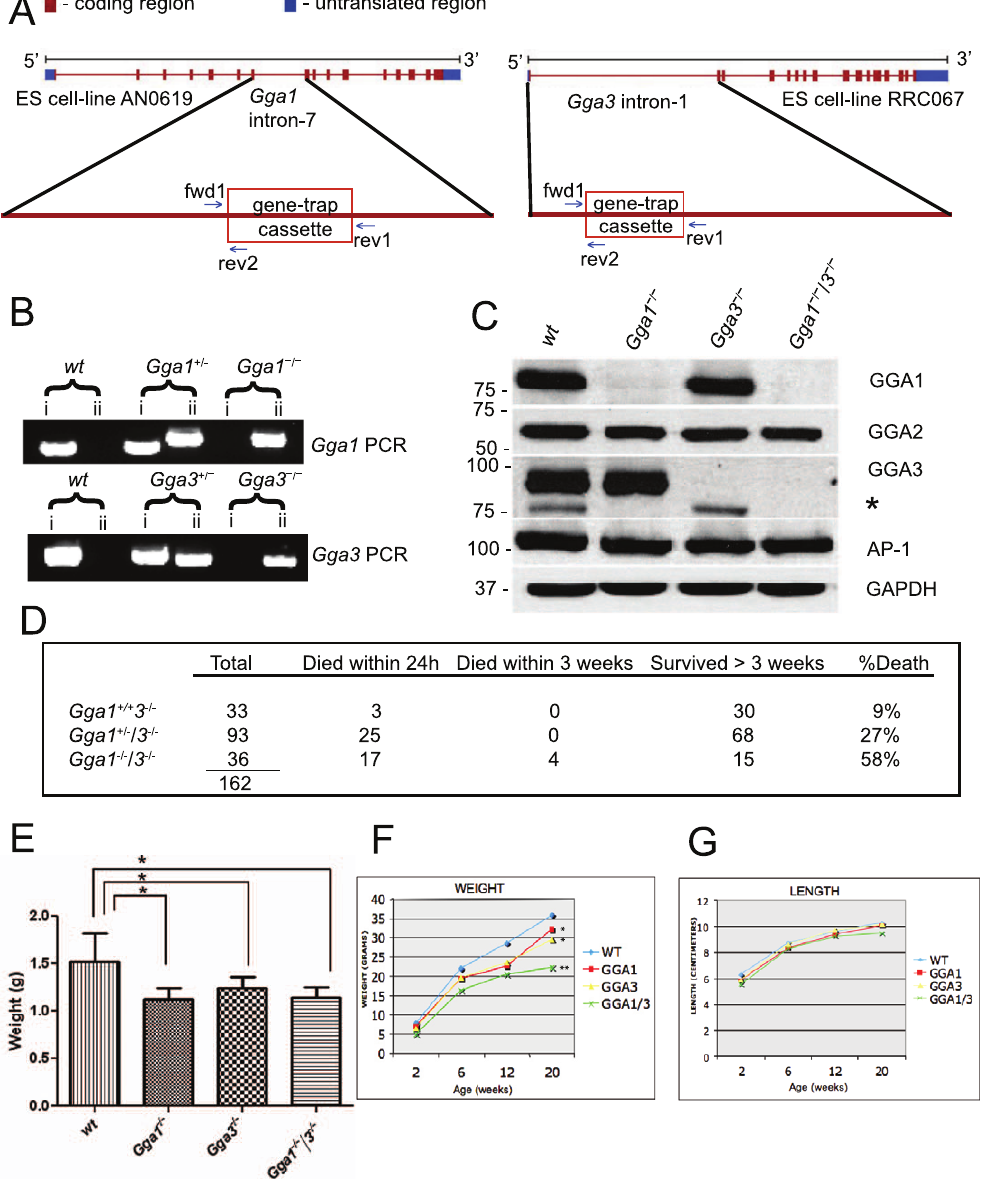
Figure 1. Analysis of Gga1 , Gga3 and Gga1/3 null mice. A) The position of the gene-trap within intron-7 of the mouse Gga1 gene is shown along with the position of the gene-trap within intron-1 of the mouse Gga3 gene. As a consequence of these gene-traps, normal mRNA is disrupted by the splice acceptor site of the engrailed-2 leader sequence fusing with either codon-203 (encoding E203) of the mouse Gga1 gene or codon-14 (encoding S14) of the mouse Gga3 gene. Gga1 and Gga3 PCR primer sets fwd1/rev1 and fwd1/rev2 (Figure S1A) were used to distinguish between wt and null genotypes, respectively. B) PCR of genomic DNA was performed using Gga1 specific primers, ( Gga1 PCR, reaction i) Gga3 specific primers ( Gga3 PCR, reaction i), and a Gga1 specific primer or Gga3 specific primer in combination with a gene trap specific primer (reactions ii). PCR band in reactions (i) indicates wt genotype, while PCR band in reactions (ii) indicates null genotype. C) Western blot analysis of mouse brain lysates probed for GGA1, GGA2, GGA3, AP-1 and GAPDH (loading control). * denotes a GGA1- cross reacting band (see Figure S4). D) Gga1 + / 2 /Gga3 2 / 2 6 Gga1 + / 2 /Gga3 2 / 2 matings were set up and the resulting mice were genotyped by PCR as described in panels A and B. E) Birthweights were obtained on day 1 and plotted according to genotype ( wt , n=10; Gga1 2 / 2 , n=23; Gga3 2 / 2 , n=20; Gga1 2 / 2 / 3 2 / 2 , n=20). * represents p= , 0.001; as determined by Student’s t-test. F and G) Weights and nose-rump lengths (NRL) of wt (blue), Gga1 2 / 2 (red), Gga3 2 / 2 (yellow) and Gga1 2 / 2 /3 2 / 2 (green) mice were obtained at the times indicated and plotted versus age in weeks. * represents p , 0.05, ** represents p , 0.001; as determined by Student’s